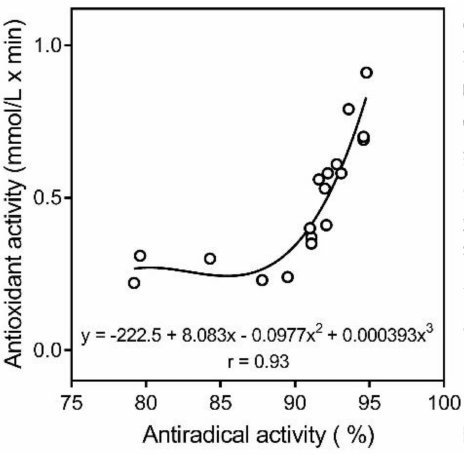
Figure 5. Polynomial extrapolation of antiradical activity in the DPPH assay versus antioxidant activity in the electrochemical assay for all 18 HA